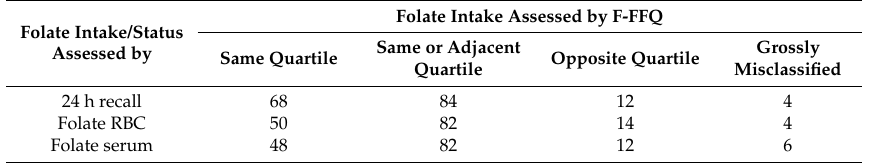
Table 5. Cross ‐ classification (%) of folate intake into quartiles by the F ‐ FFQ and validation methods (the average of three 24 h recalls and biomarkers of folate status, i.e., serum and red blood cells (RBC folate concentrations) for 50 participants of validation subsample, Serbian women of reproductive age.